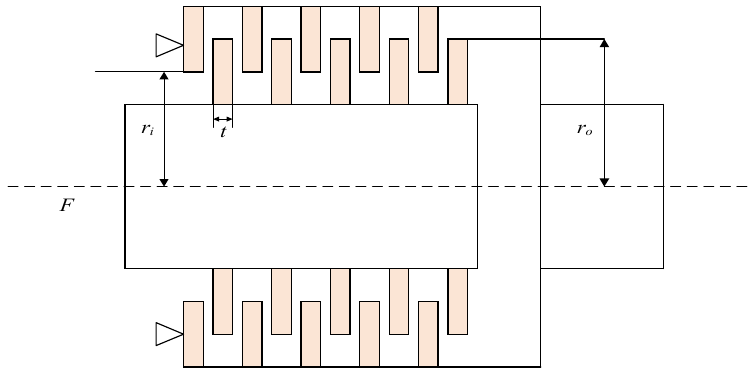
Figure 15. Model of multiple disc clutch brake.